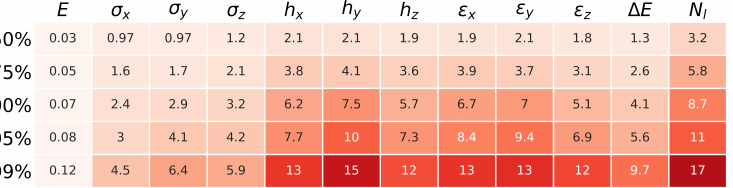
Figure A2. Prediction error for the inverse prediction of the IsoDAR model. This estimates how close the predicted machine settings approach the target beam. The rows represent the various confidence levels.